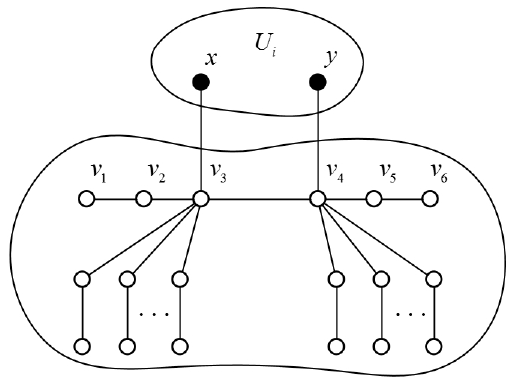
Figure 4. The operation O 6